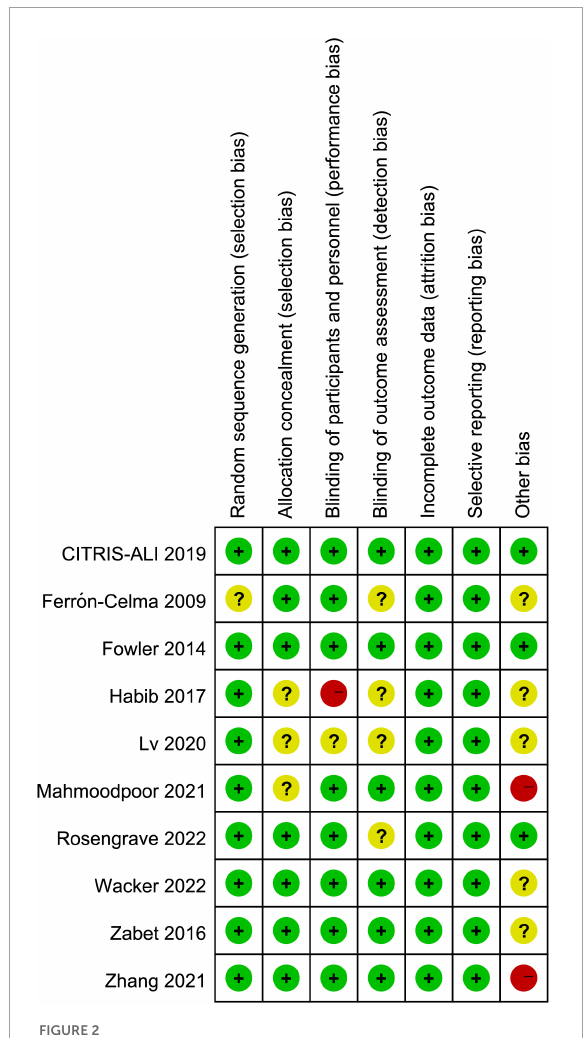
FIGURE2 Assessment of quality by the Cochrane risk of bias tool.